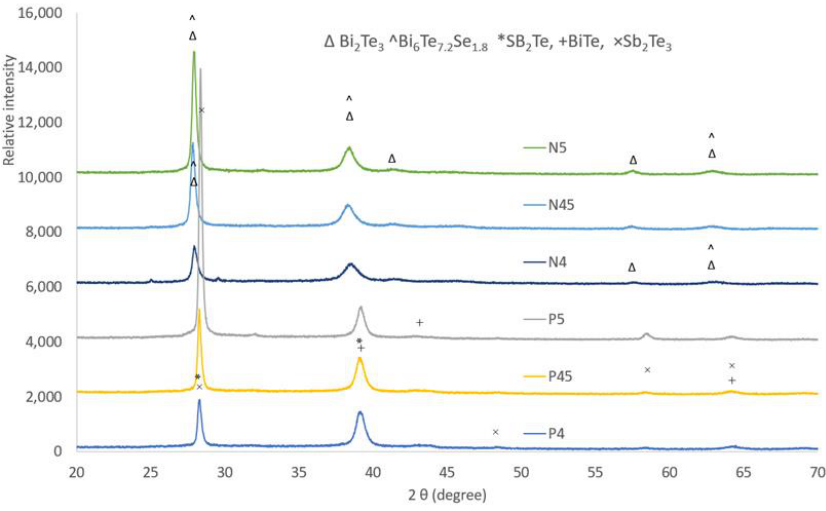
Figure 5. XRD comparison of different N-type and P-type layers on silicon substrate.